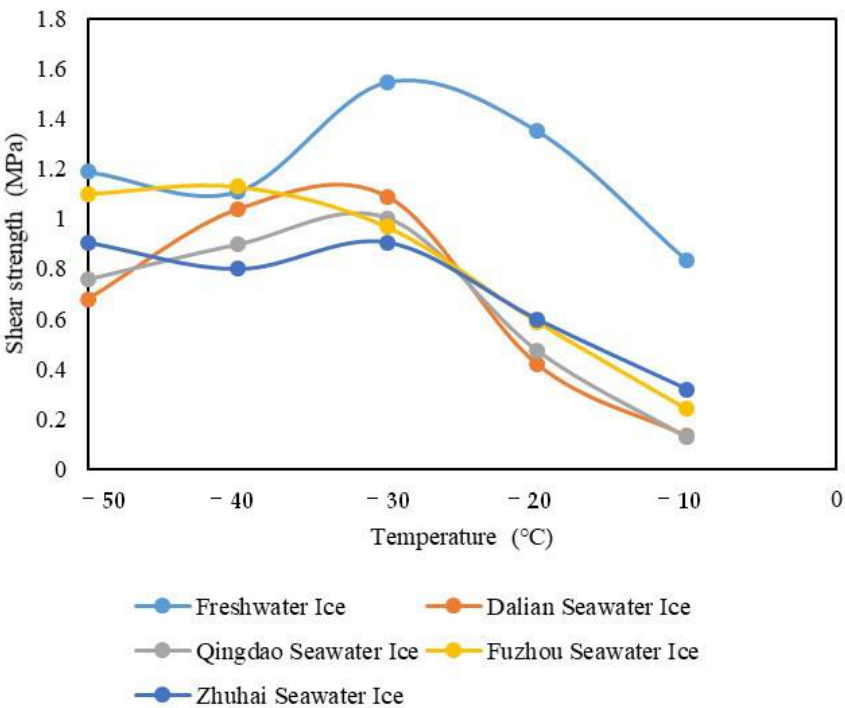
Figure 20. Comparison of shear strengths of seawater and freshwater. Figure 21. Comparison of shear strengths of seawater and freshwater.